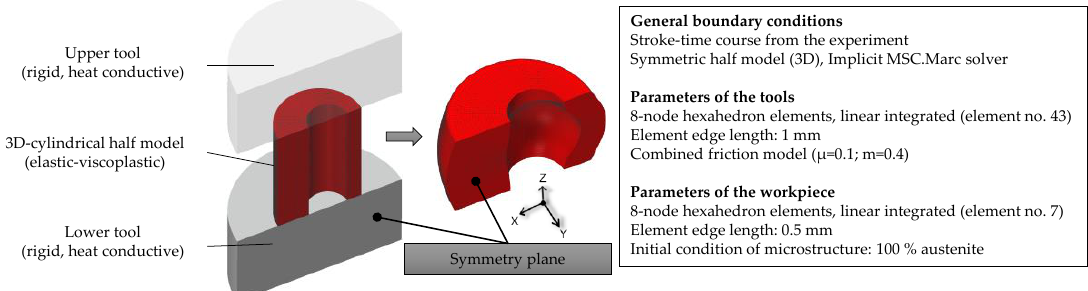
Figure 2. Design of the investigated FE simulation model, with boundary conditions [10].